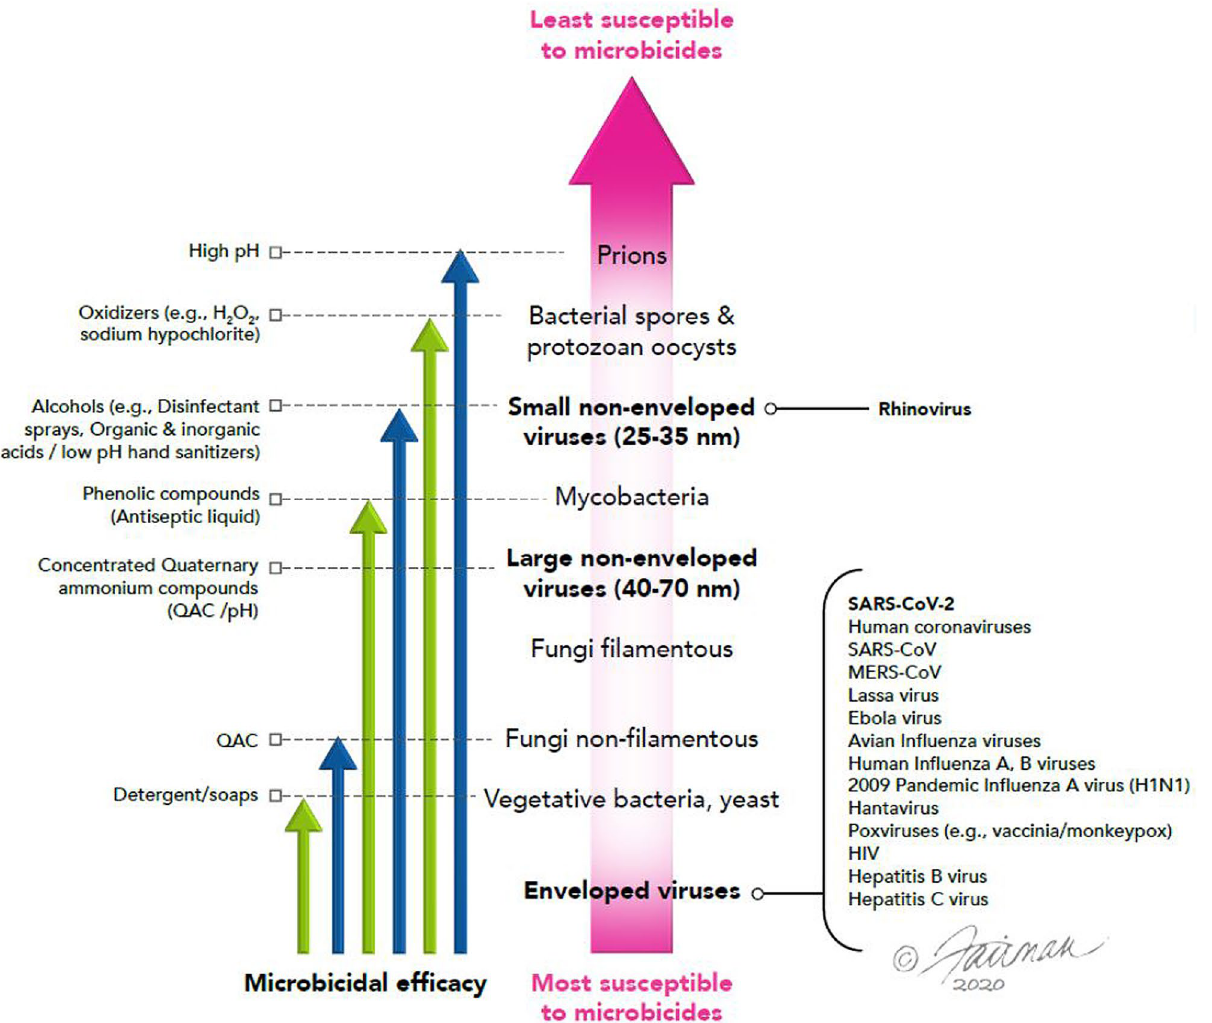
Figure 1. Heirarchy of susceptibility of pathogens to microbicidal active ingredients. Certain formulated microbicides may include combinations of active ingredients, resulting in synergistic virucidal efficacy greater than that displayed by the individual active ingredients (modified from Sattar 8